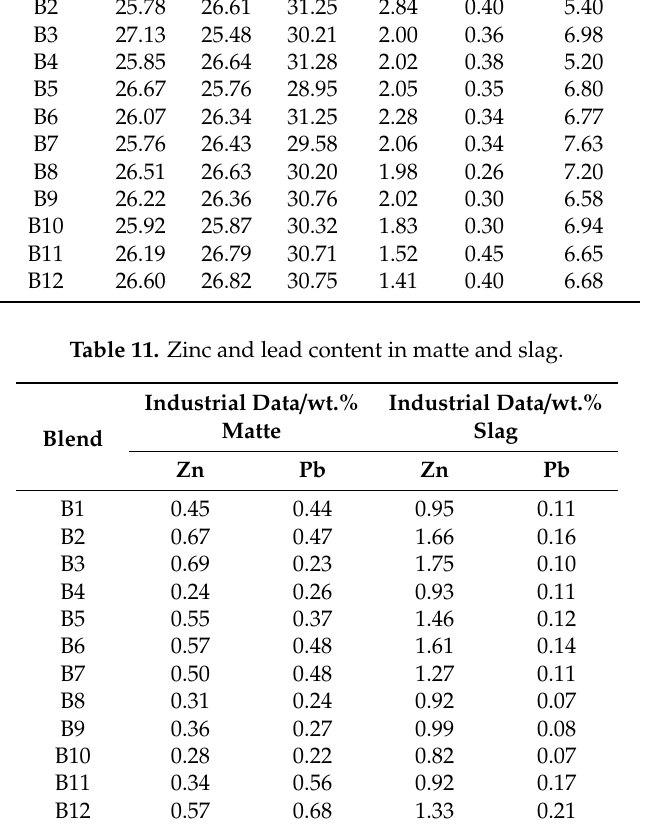
Table 10. Chemical composition of the blends studied. Blend